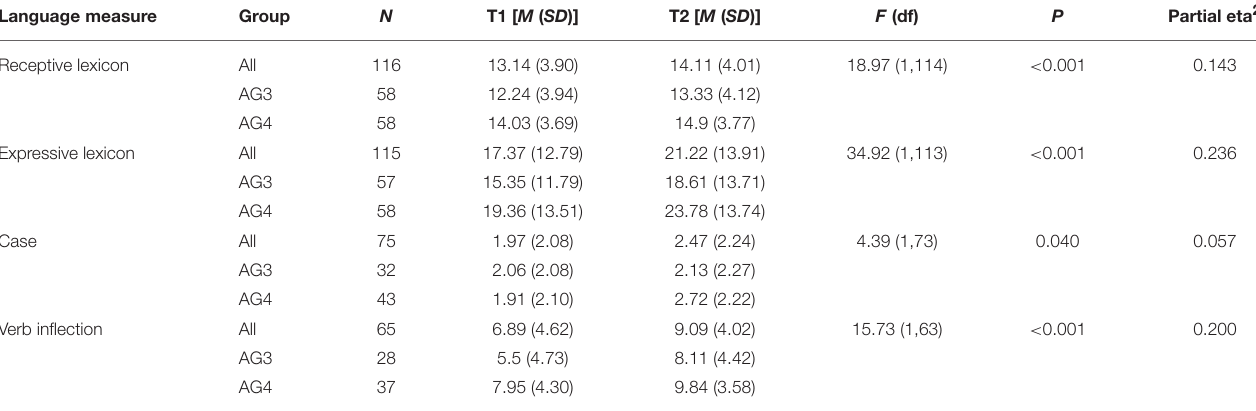
TABLE 5 | Descriptive statistics for the total sample (all) as well for the single age groups (AG3, AG4) and report of main effects of ANOVAs for testing time (T1-T2). Language measure Group Receptive